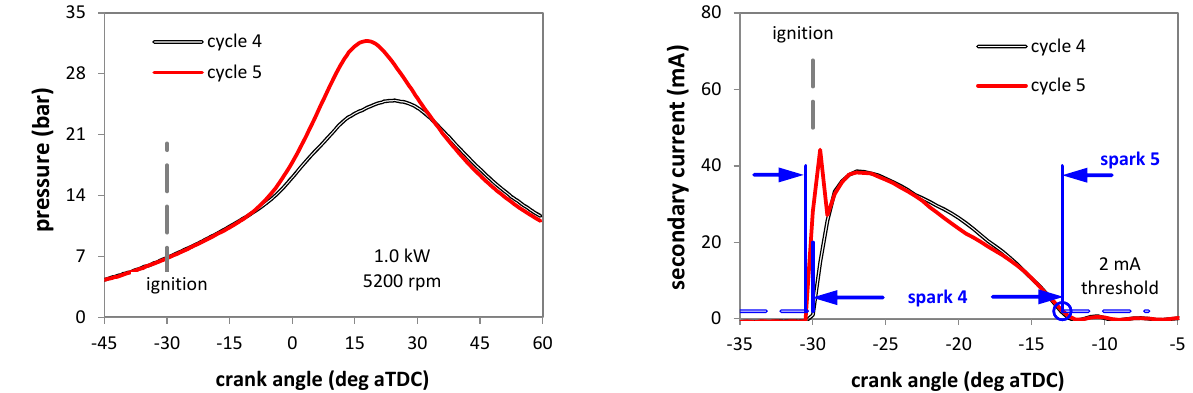
Figure 4. Raw signals acquired during two consecutive cycles at the 1.0 kW load.